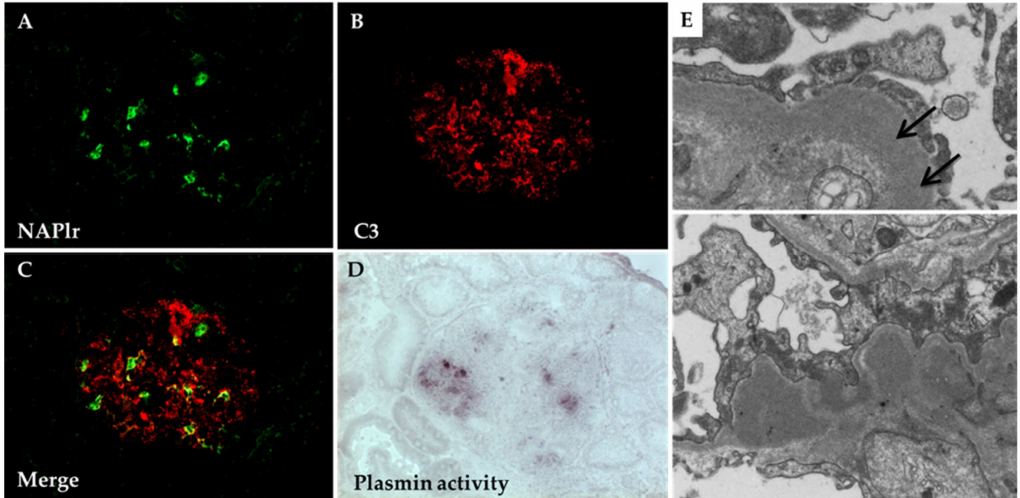
Figure 18. Kidney biopsy findings of C3 glomerulopathy with glomerular NAPlr deposition and associated plasmin activity. ( A – C ): Double immunofluorescent staining for NAPlr (fluorescein isothiocyanate, green) and complement C3 (Alexa Fluor 594, red). NAPlr ( A ) and C3 ( B ) were both positive in the glomeruli, and their localization was essentially different in the merged images ( C